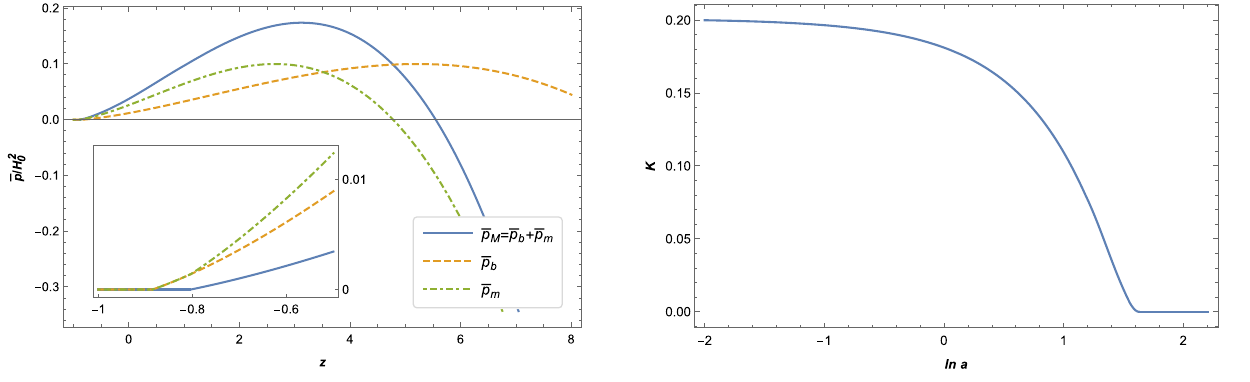
Fig. 2 Evolutionsoftheeffectivepressuresofthetotalmatter,baryonic matter and dark matter, plotted in unit of H 2